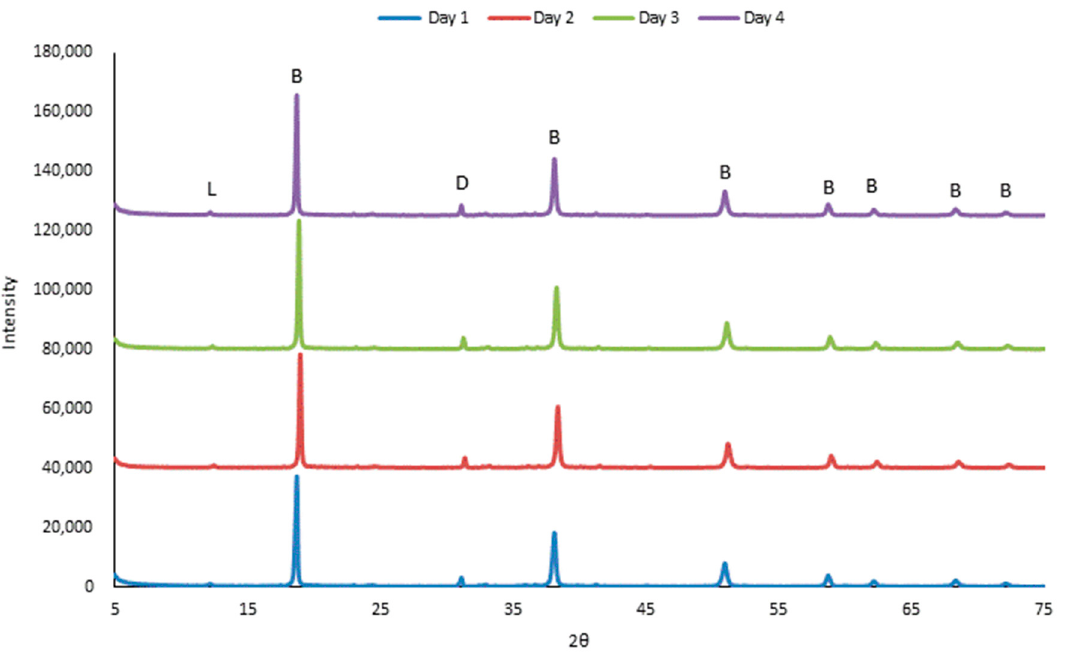
Figure 2. XRD overlay diffractograms of the coating samples during the acid spraying test application; L: Lizardite, B: Brucite, D: Dolomite.